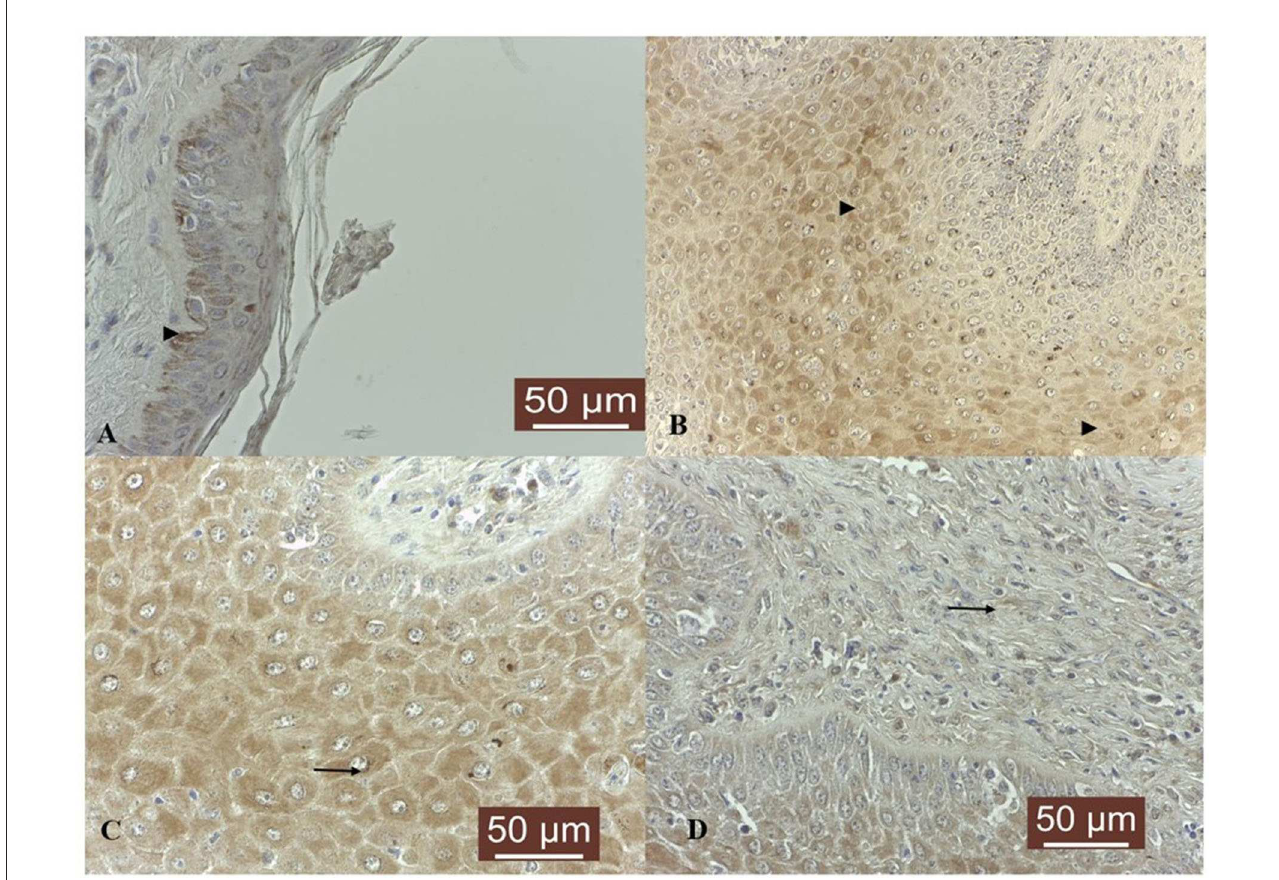
FIGURE2 TIMP-3 immunoexpression in bovine normal skin and fibropapillomas: (A) TIMP-3 is detected as moderate cytoplasmic (black arrow) pattern in normal skin basal cell layer; 40 X. (B) In tumor samples, TIMP-3 expression was recorded as a weak to moderate finely granular staining pattern in the cytoplasm of upper epithelial cells (black arrowheads); 20 X. (C) Note a detailed TIMP-3 moderate granular cytoplasmic and perinuclear pattern (black arrow) in spinous layer; 40 X. (D) Fibroblasts showed a weak cytoplasm and perinuclear immunoreactivity (black arrow); 40 X. Streptavidin-biotin-peroxidase staining.